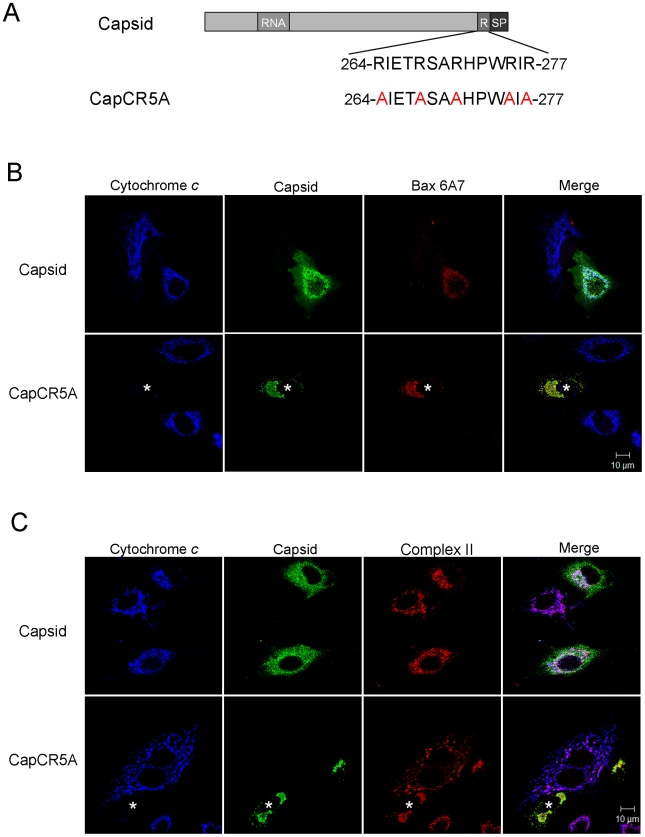
The arginine-rich motif in capsid protein is not required for targeting to mitochondria or activation of Bax.A. In the CapC5RA mutant, 5 arginine residues in the R motif were changed to alanines. RNA  =  RNA binding site; R =  arginine-rich motif; SP  =  E2 signal peptide. B. A549 cells were transfected with plasmids encoding wild type capsid or CapC5RA. At 40 hours post-transfection, cells were processed for indirect immunofluorescence using goat anti-RV, rabbit anti-cytochrome c and a mouse monoclonal antibody specific for activated Bax (6A7). Asterisk denotes a cell expressing CapC5RA that has loss its mitochondrial stores of cytochrome c. C. Samples were processed as in panel B except that a mouse monoclonal antibody to Complex II was included (instead of anti-Bax) to show that CapCR5A was targeted to mitochondria. Scale bars  = 10 µm.